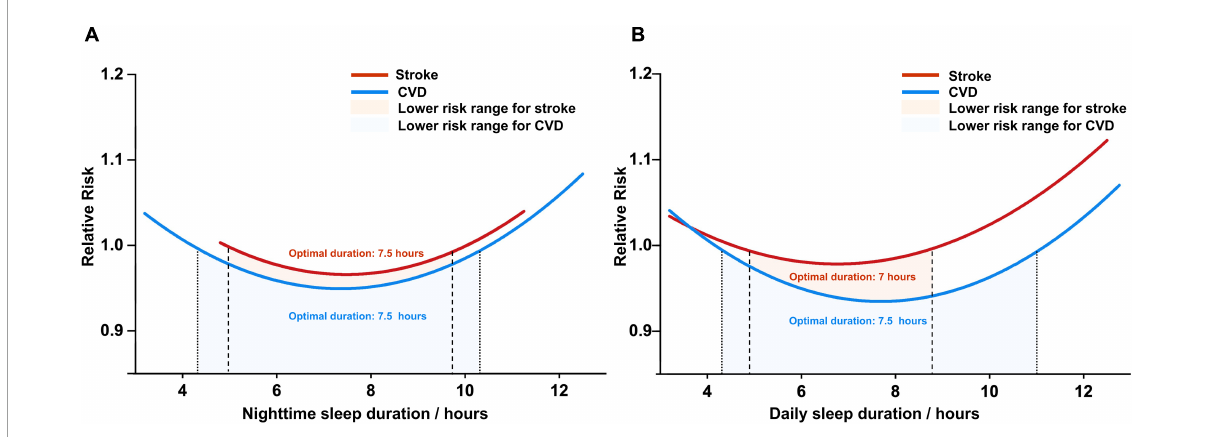
FIGURE2 The dose-response analysis of cardio-cerebrovascular disease and sleep duration, (A) for nighttime sleep duration and (B) for daily sleep duration. CVD, cardiovascular